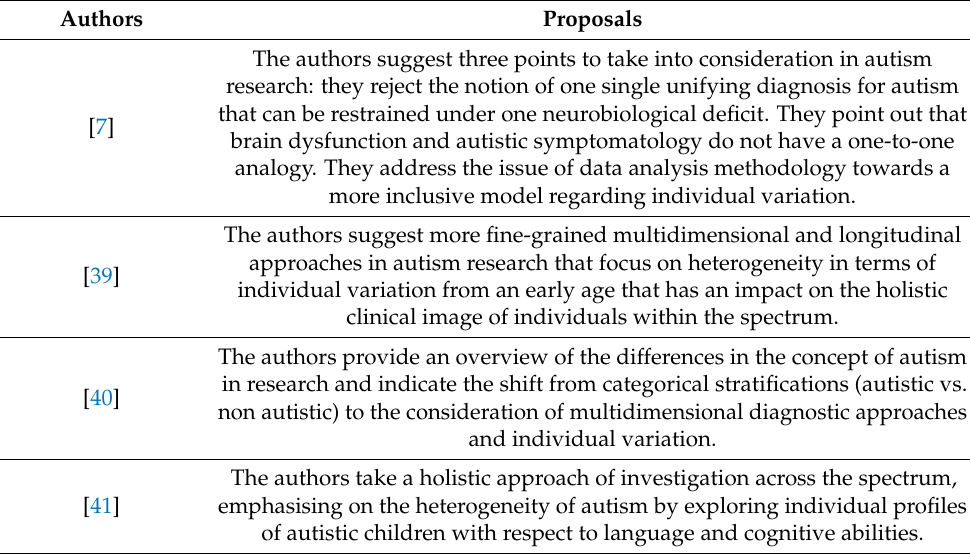
Table 2. Overview of the selected research studies with respect to heterogeneity and individual variation in autism spectrum